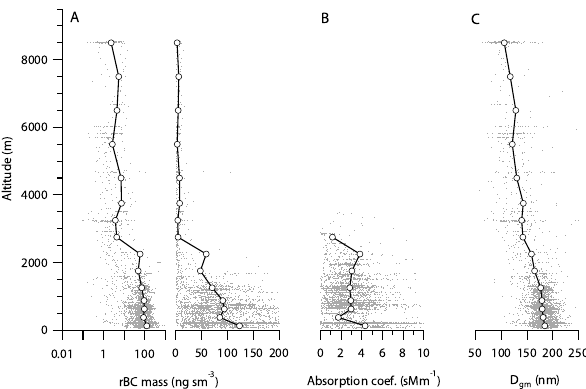
Fig. 5. Profiles of (a) refractory black carbon (rBC) mass concen- trations on log and linear scales, (b) absorption coefficient and (c) rBC mass mean diameter for all flights. Individual 30-s averaged points are shown in gray; mean values for 250 to 1000m thick alti- tude bins are shown by black circles.